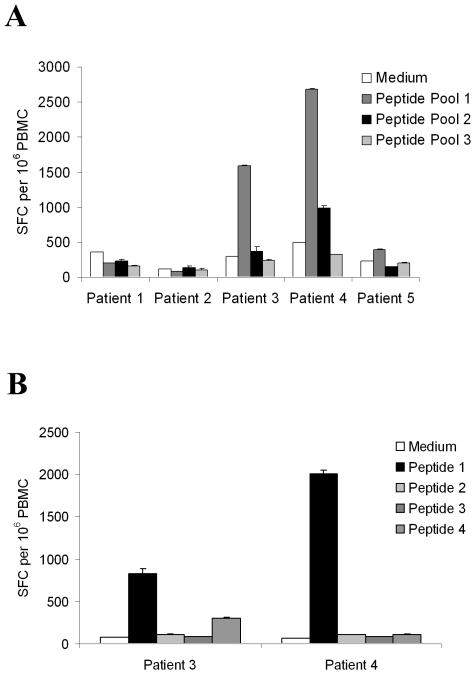
Analysis of the recognition of HLA-Cw*0102-binding HIV-1 peptides by T cells from HLA-Cw*0102-positive HIV-infected individuals.PBMCs from clade B HIV-infected individuals were screened for responses to (a) pools of HLA-Cw*0102-binding peptides (pool 1 =  peptides 1–4; pool 2 =  peptides 5–8; pool 3 =  peptides 9–11) or (b) individual peptides (1–4) by IFN-γ ELISPOT assay. The number of cells producing IFN-γ in response to stimulation with peptide(s) or medium alone is shown, expressed as the mean (of results obtained in duplicate test wells) number of spot-forming cells (SFC) per 106 PBMCs. The error bars indicate 1 standard deviation above the mean.